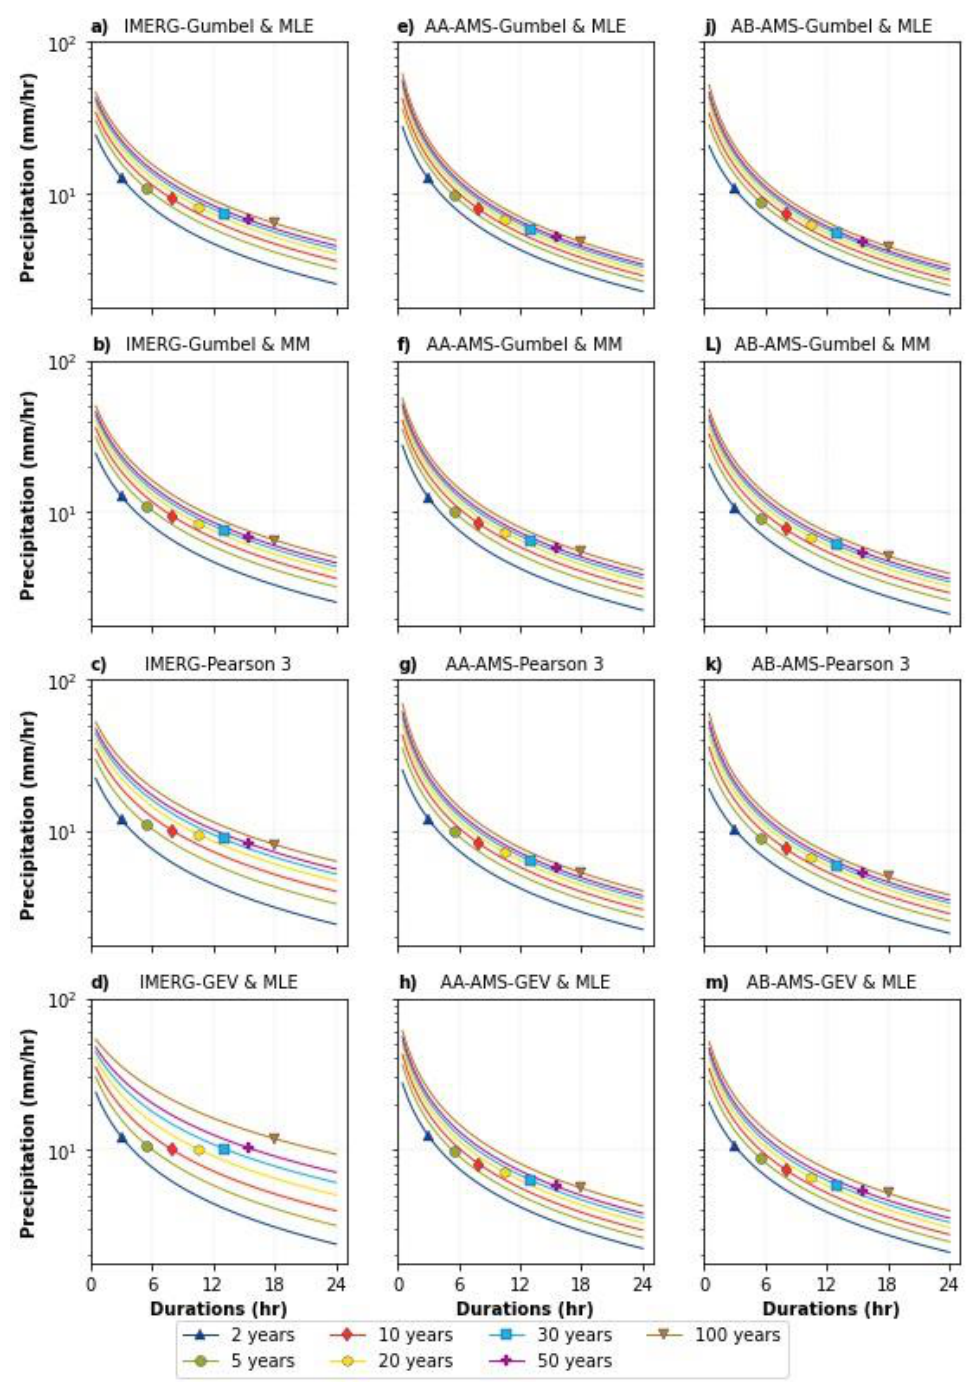
Figure A6. IDF curves fitted with the four CDFs over FBR 1 for the 2, 5, 10, 20, 30, 50, and 100 year return periods and durations from half-hour to 24 h. From left to right: IMERG, AA-AMS, and AB-AMS. From top to bottom: Gumbel and MLE, Gumbel and MM, Pearson 3, and GEV and MLE The marker’s purpose is only to distinguish the IDF curves.